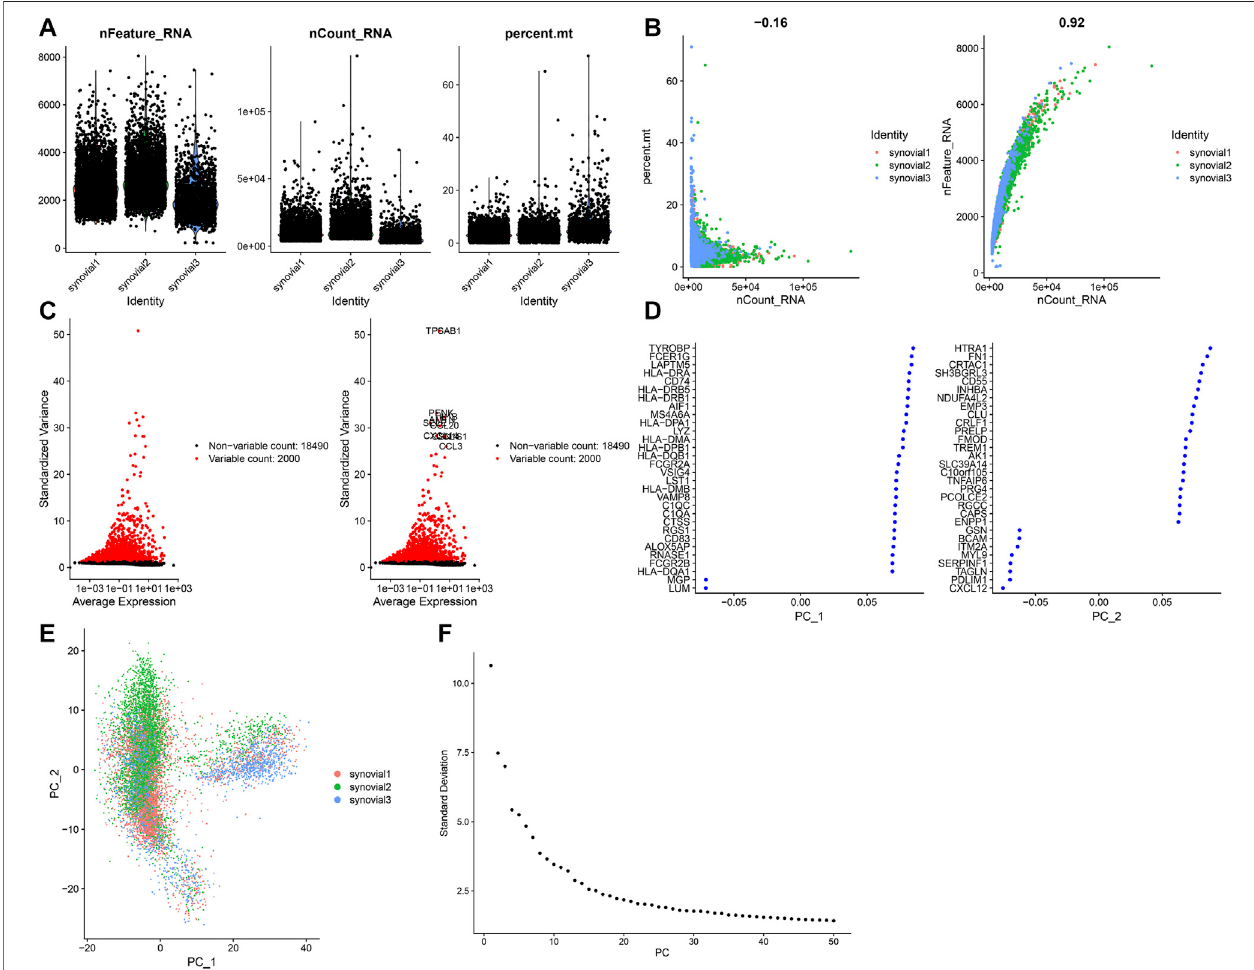
FIGURE5| QualitycontrolofscRNA-seqofosteoarthriticsynoviocytesintheGSE152805dataset. (A) Violinplotsofthenumberoffeaturegenes,thecountoftotal genes and the percent of mitochondrial genes after fi ltration. (B) Scatter plots of correlations of the count of total genes with the percent of mitochondrial genes and the number of feature genes. (C) The top 2000 highly variable genes and visualization of the top ten genes. (D,E) Visualization of dimensionality reduction results of the scaling data. (F) Elbow plot for identifying the optimal number of